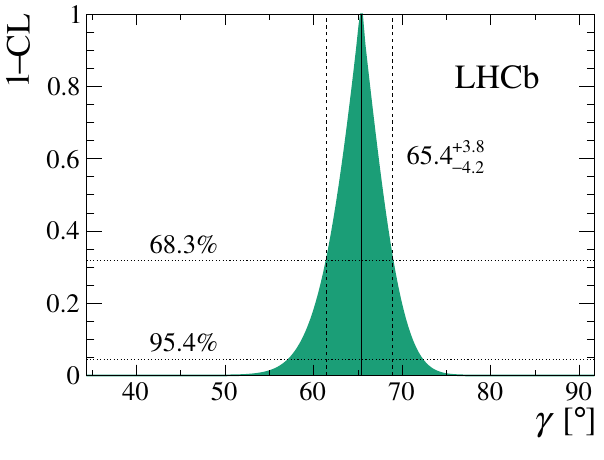
Figure 9 . One dimensional 1 − CL profile for γ from all inputs used in the combination.